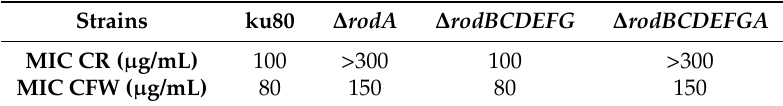
Table 1. CMI values of hydrophobin mutants and the parental strain ku80 incubated in presence of congo red or calcofluor white for 48 h at 37 °C in MM medium. No statistically significant difference was found in the CMIs for each drug.